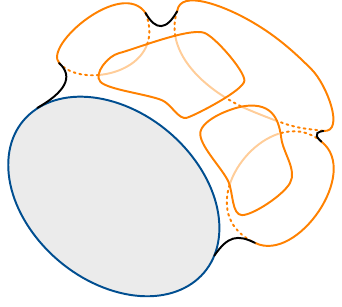
Figure 9: Disk that is torn apart because of the proliferation of macroscopic holes [ 64 ] . The blue boundary indicates an asymptotic boundary and the large orange holes are where the spacetime ends on ghost-branes. In reality these orange bound- aries are much larger and the spacetime just consists of thin